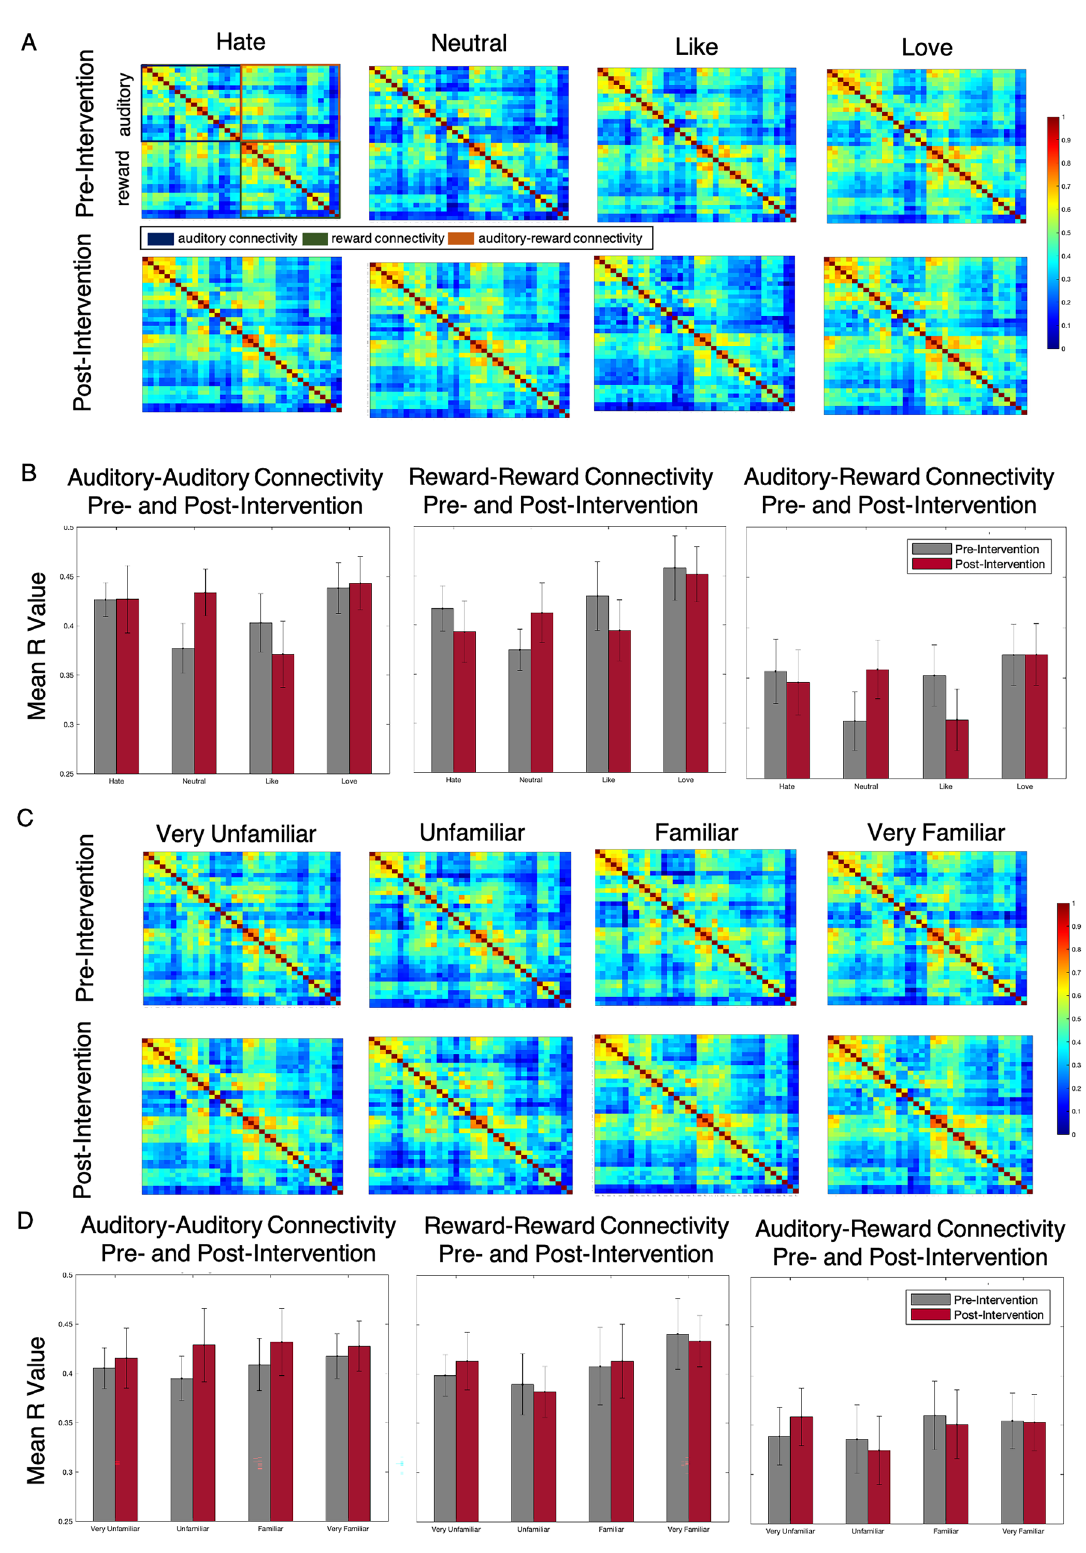
Figure 4. ( A and C ) Correlation matrices showing the relationship between auditory and reward regions for different liking ( A ) and familiarity ( C ) ratings. ( B and D ) Bar graphs depicting overall connectivity between auditory-auditory, reward-reward, and auditory-reward regions for different liking ( B ) and familiarity ( D )